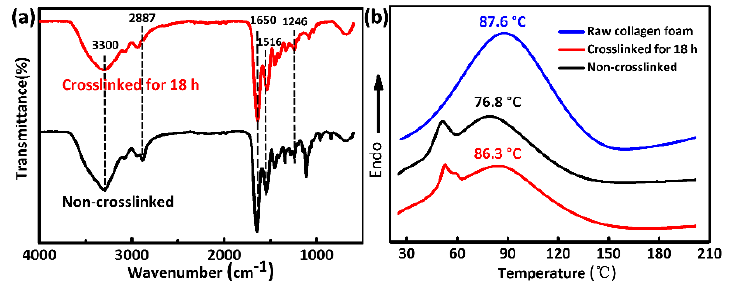
Figure 5. FTIR spectra of collagen/PEO nanofibrous membranes non-crosslinked and crosslinked for 18 h ( a ) and DSC thermogram of raw collagen foam, collagen/PEO nanofibrous membranes non-crosslinked and crosslinked for 18 h ( b ).